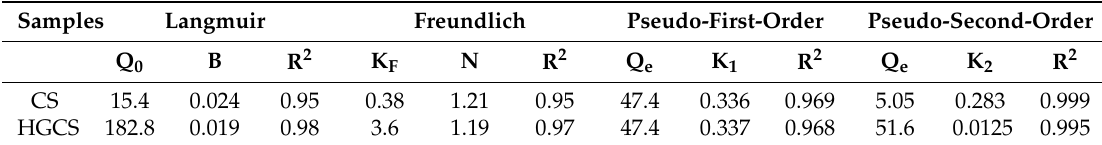
Table 1. Kinetics parameters of Langmuir and Freundlich models in the case of MB adsorption. Samples Langmuir